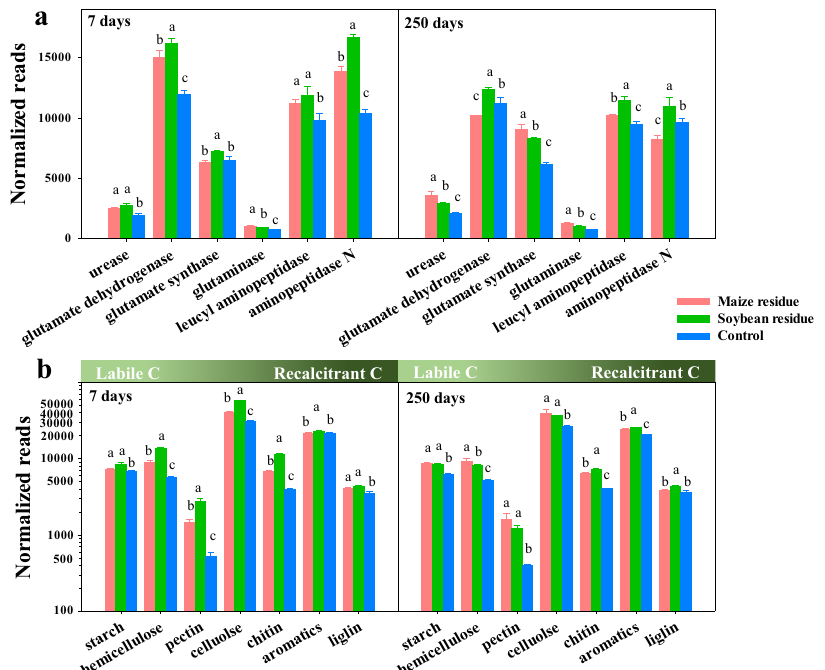
Fig. 4 Microbial metabolic pro fi le. Normalized reads of N-mineralization ( a ) and C-decomposition ( b ) genes in response to the amendment of maize and soybean residues after incubated at 25 °C for 7 and 250 days. Different letters above bars indicate signi fi cant differences among treatments at p < 0.05 (one-way ANOVA). Error bars are the standard error of three replicates.